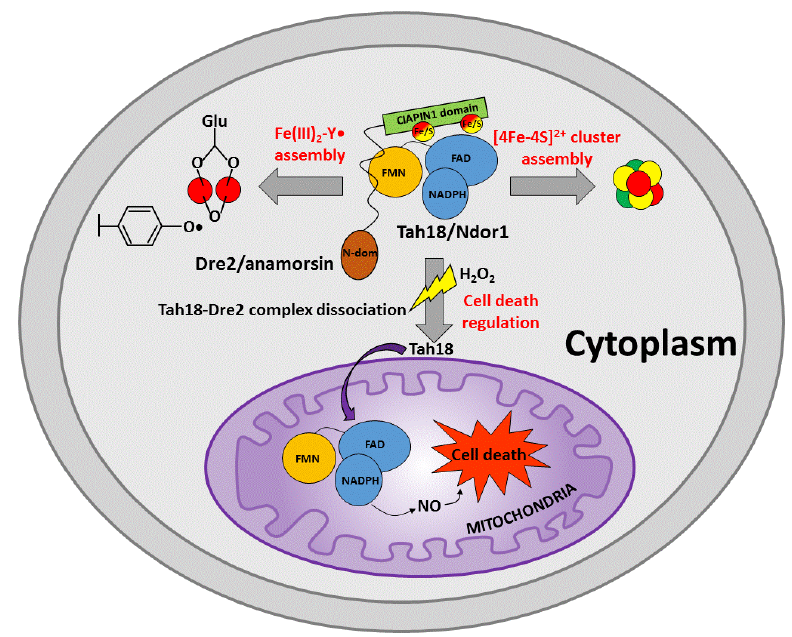
Figure 2. The three cellular processes that involve CIAPIN1 proteins (Dre2 and anamorsin) once complexed with the NADPH-dependent diflavin oxidoreductase 1 (Tah18 and Ndor1). Red sphere is Fe(III) ion, green sphere is Fe(II) ion, yellow sphere is sulfide ion and red/yellow sphere is Fe/S cluster.